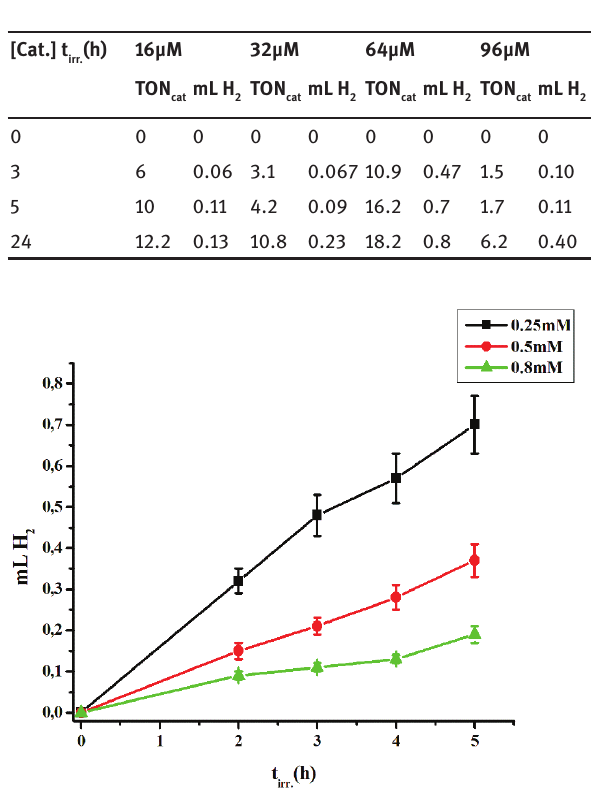
Figure 9: Hydrogen evolution with 64μΜ 2 , 0.1M AcOH, 1M TEOA in degassed acetone with different concentrations of [ReBr(CO) (0.25mM, 0.5mM, 0.8mM), during irradiation time 0-5h, at room temperature.